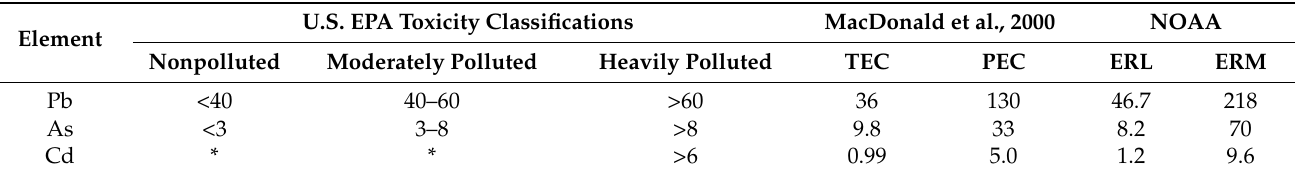
Table 3. Sediment quality guidelines (SQGs) for heavy